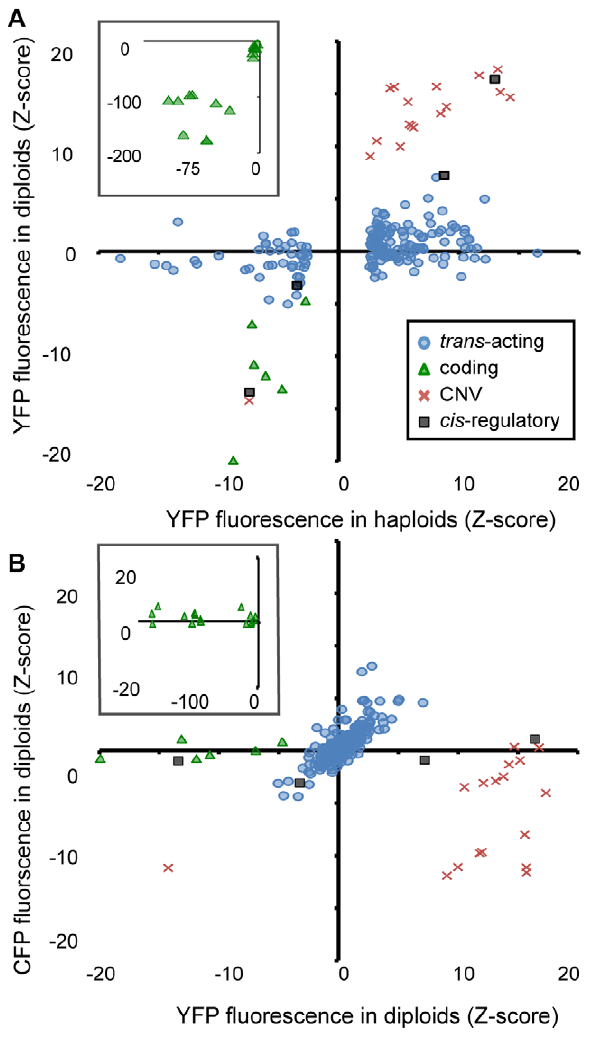
Figure 4. Effects of heterozygous mutant alleles on YFP and CFP fluorescence differ among mutational classes in diploid cells. (A) The effect of each mutant genotype on YFP fluorescence in haploid cells (X-axis) is compared to the effect of the heterozygous mutant genotype on YFP fluorescence in diploid cells (Y-axis). These diploid cells were heterozygous for the mutant P TDH3 -YFP haploid genome and a reference haploid genome containing P TDH3 -CFP . Black squares indicate cis -regulatory mutants, blue circles indicate trans - acting mutants, green triangles indicate coding mutants, and red crosses indicate CNV mutants. (B) Using the same symbols to represent the four mutational classes as in (A), the effect of each mutant on YFP (X-axis) and CFP (Y-axis) fluorescence in diploid cells is shown. Insets in (A) and (B) show only coding mutants and cover the larger ranges of Z- scores needed to plot all of the mutants in this